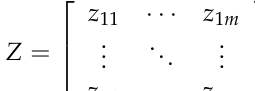
7. Getting the normalized matrix after normalization. The optimal scheme Z + consists of the maximum value of the elements in each column of Z: